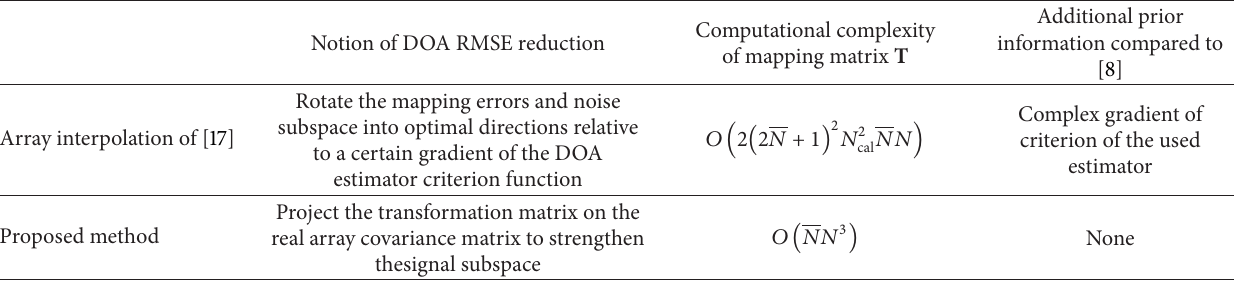
Table 1: Comparison of the two